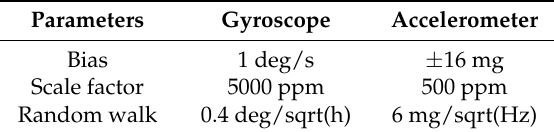
Table 1. MEMS grade IMU technical data.